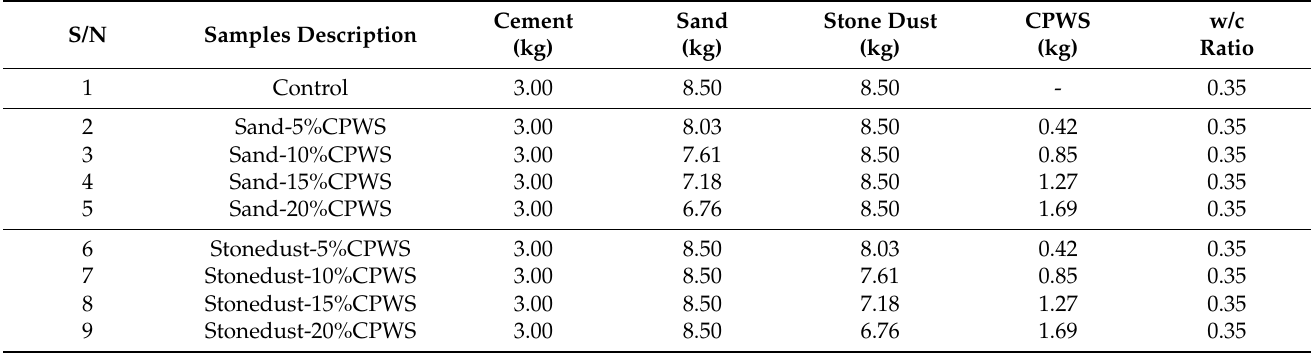
Table 1. Sandcrete block constituents mix